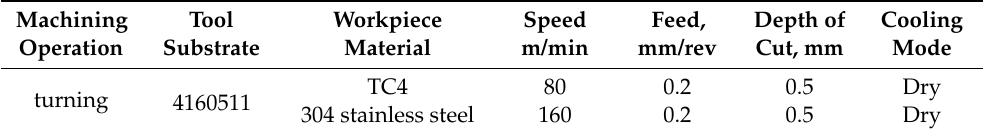
Table 2. Cutting parameters of